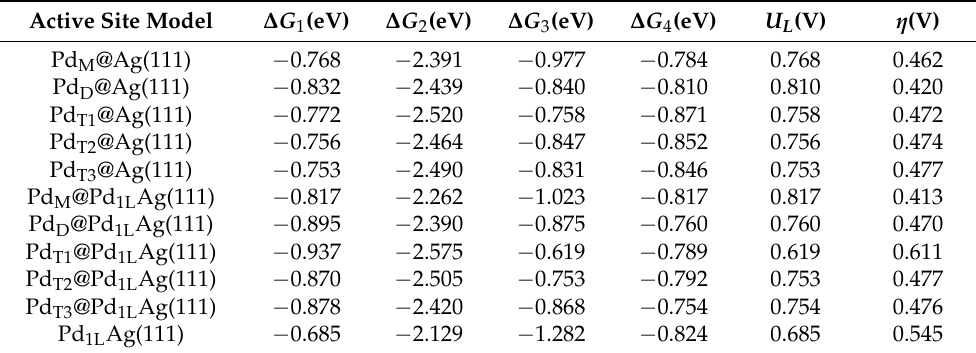
Table 2. The reaction-free energies of the four e − ORR reactions, as well as the corresponding theoretical limiting potential and